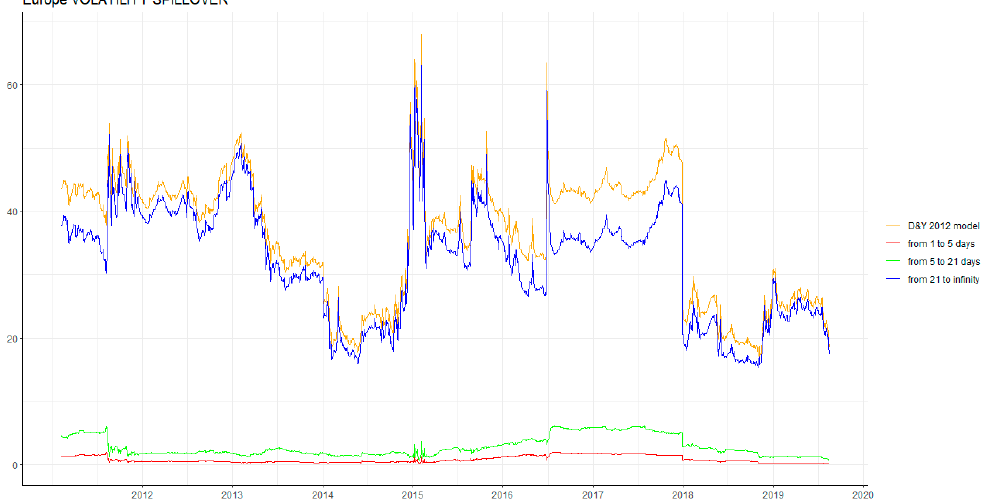
Figure A12. Total volatility spillover of DY12 and BK18 in Europe (Windows 370).